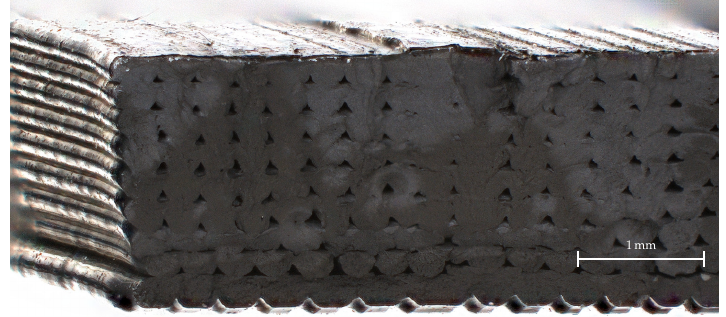
Figure 13. Microscope image of a printed CDP sample, low magnification.